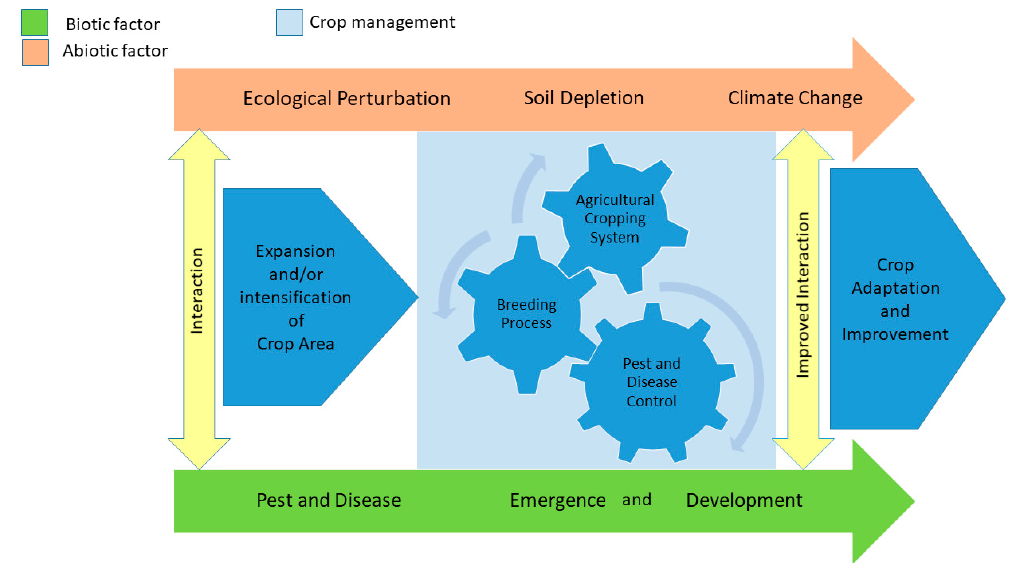
Figure 2. Evolution of cocoa cultivation, facing changing constraints.